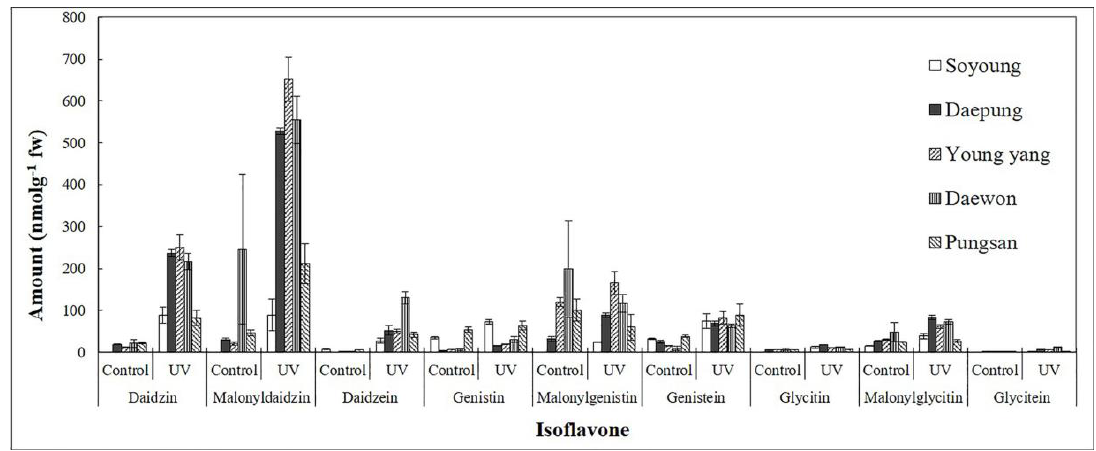
Figure 2. Isoflavone concentrations in five different cultivars of soybean leaves after 5 min UV-C treatment. The x -axis represents the different isoflavone compounds in five different cultivars and the y -axis represents the concentration of isoflavone compounds (unit: nmol g − 1 of fresh weight). The error bars represent the means ± standard deviation ( n = 3).